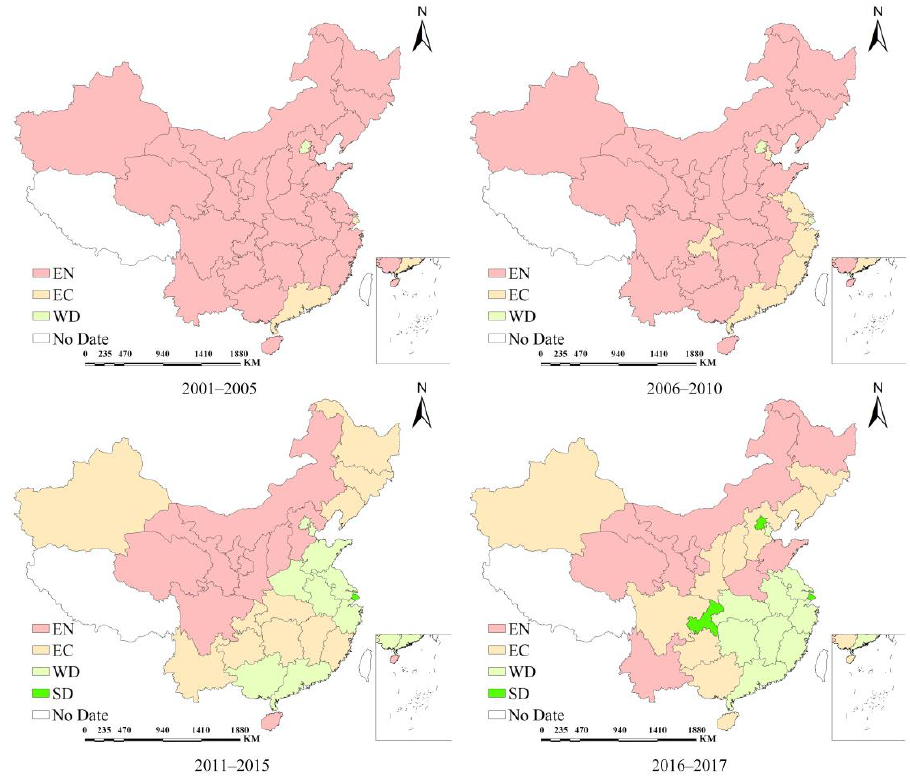
Figure 3. The decoupling evolution between carbon emissions and the PDI. In the 13th Five-Year Plan period (2016 – 2017), the number of provinces in the EN state has further decreased, and some provinces, including Beijing, Shanghai and Chong- qing, appeared in the SD state, showing an ideal direction of decoupling evolution. How- ever, there are also some provinces that showed the opposite direction of evolution. For example, in the 12th five-year period, Shandong and Henan are in the WD state, Yunnan is in the EC state and from 2016 to 2017, the three provinces are in the EN state again. This may be due to the lack of complete data for the 13th Five-Year Plan (2016 – 2020). As men- tioned above, the short-term decoupling relationship is susceptible to the effects of varia- ble tiny changes. Still, it is a reminder to managers that they need to continue to reduce carbon emissions as they develop to prevent carbon emissions from rising again.